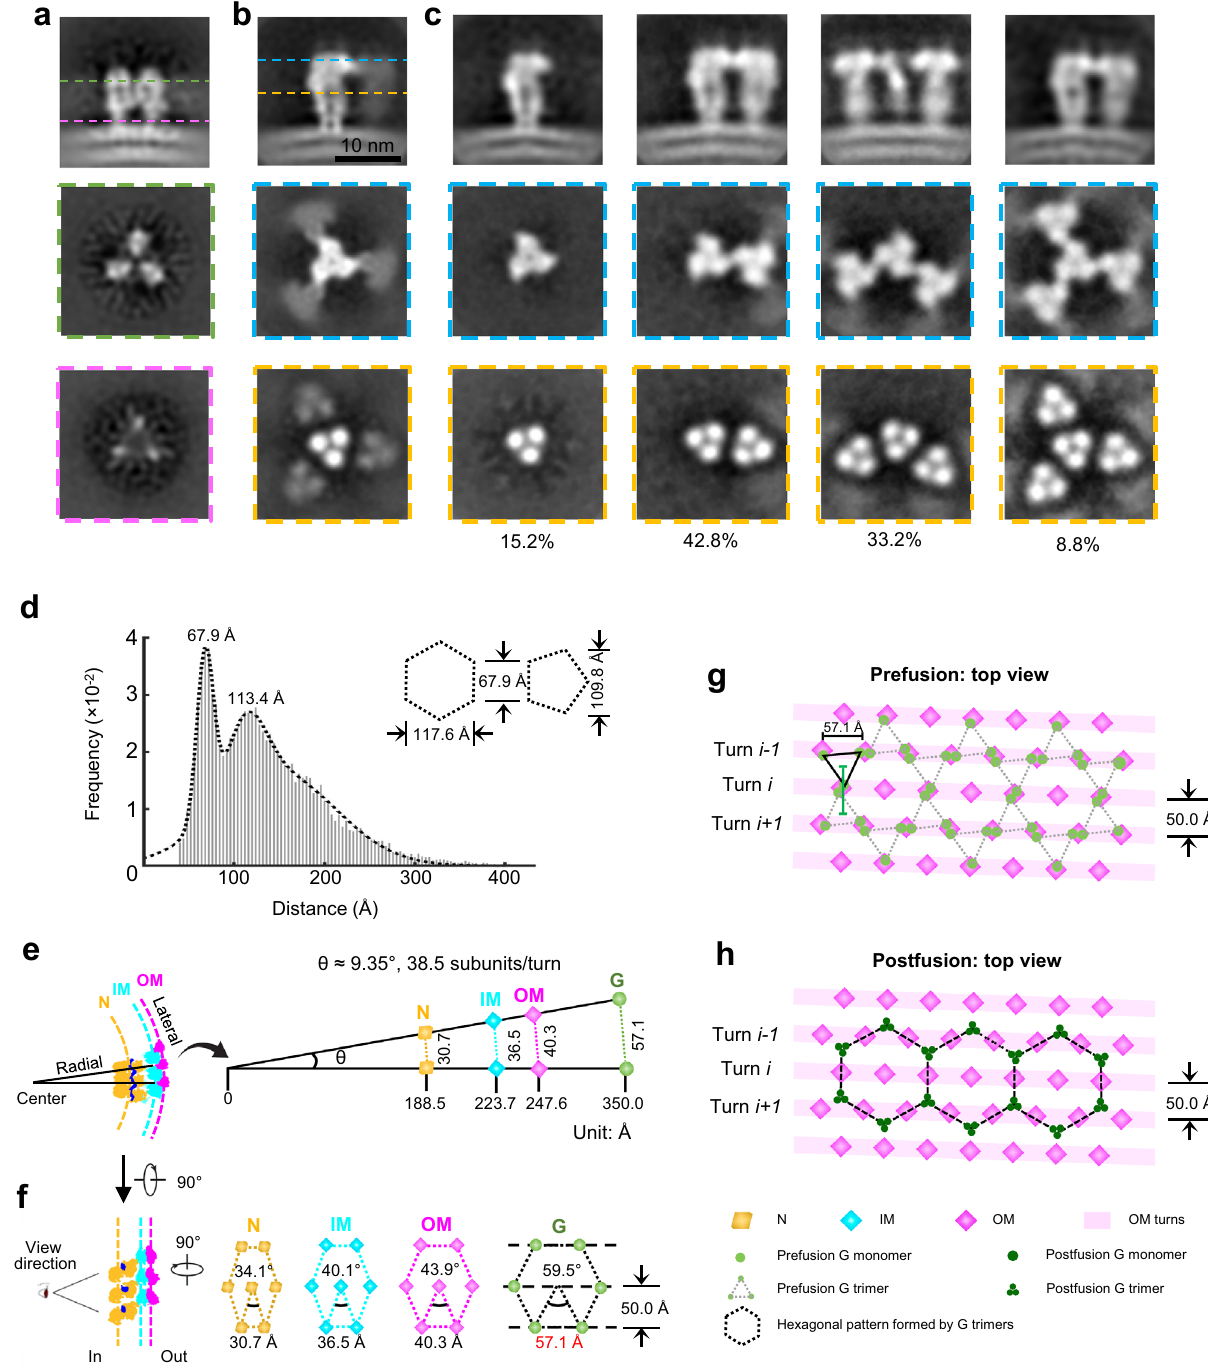
Fig. 5 | The super-complexes of G trimers visualized by subtomogram aver- aging and the relationship between the spatial organization of OM and G. a Averaged density maps of G trimer in prefusion conformation. Images in the secondandthirdrowareorthogonalsliceviews;locationsareindicatedbygreenand magenta dashed lines in the fi rst image. No adjacent densities show in the ortho- gonal views. b , c Averaged density maps of G trimer in postfusion conformation before classi fi cation and G trimers classi fi ed by different numbers of neighboring G trimers(super-complexes). b Theaverageddensitymapof allsubtomograms. c The averaged densitymaps of Gtrimerwith 0( fi rstcolumn), 1(secondcolumn),2(third column)and3(fourthcolumn)neighboringGtrimers.Imagesinthe fi rstrowareside viewsoftheaverages;imagesinthesecondandthirdrowareorthogonalsliceviews; locations are indicated by blue and golden dashed lines in the fi rst image. d Distribution of the distances of the fi rst fi ve nearest neighbors for each G trimer.